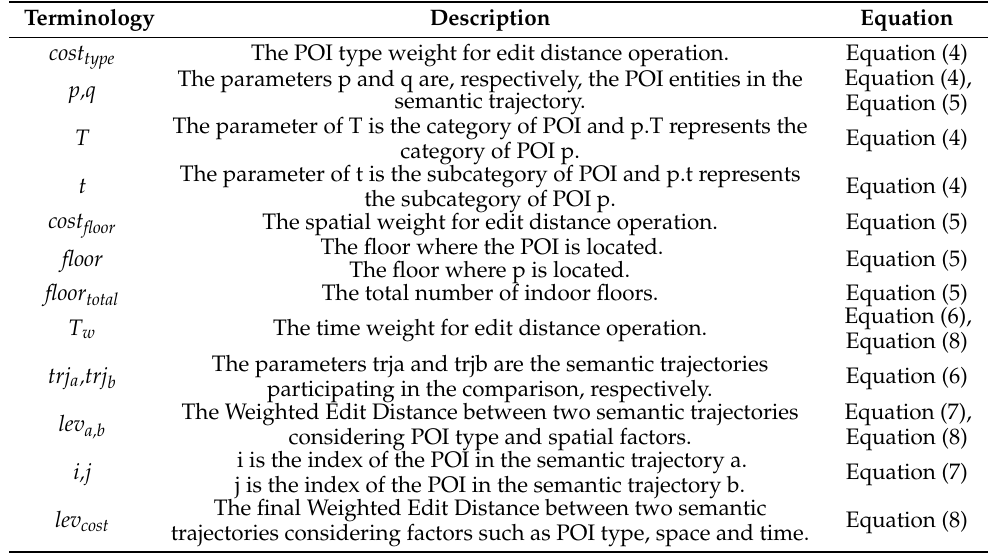
Table 1. The terminology illustration of weighted edit